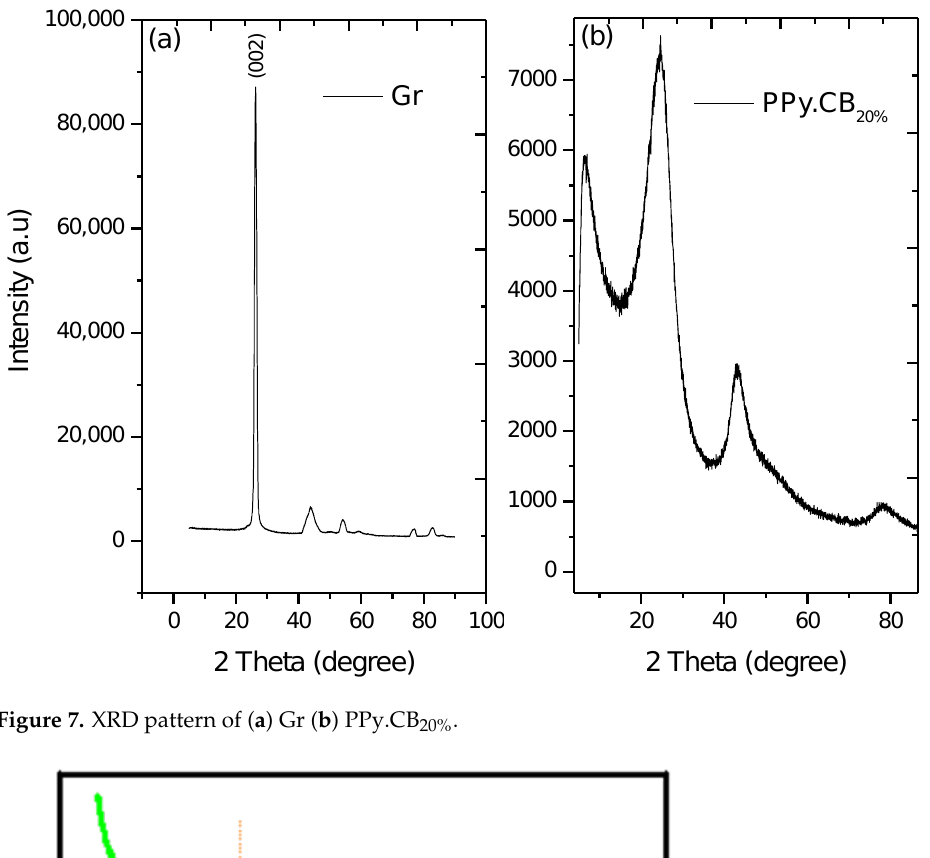
Figure 7. XRD pattern of ( a ) Gr ( b ) PPy.CB 20% .